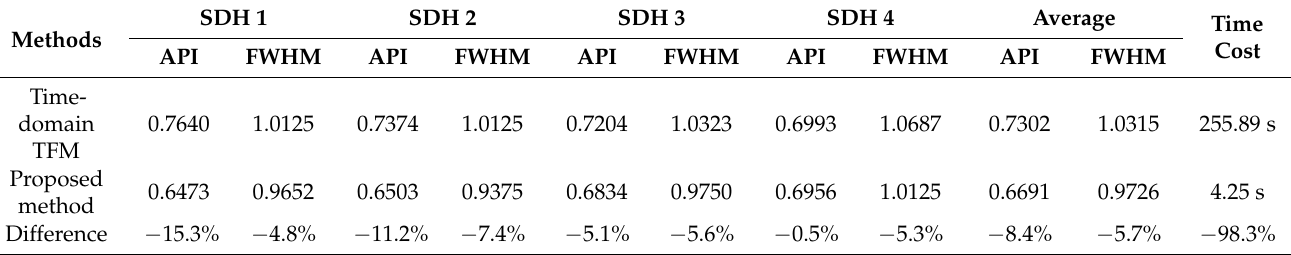
Figure 8. Normalized amplitudes of the results reconstructed by TFM and the proposed method. Table 4. APIs, FWHMs and time costs with different imaging methods in experiment A.